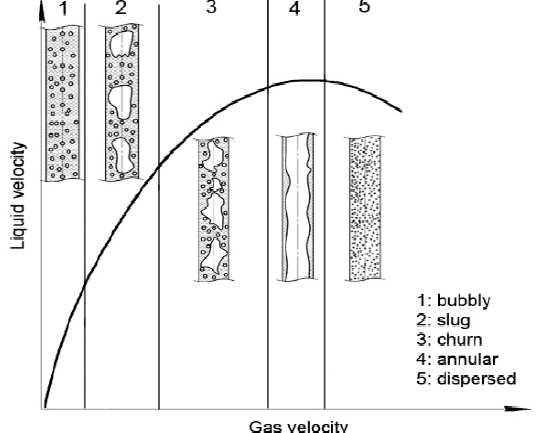
Figure 3. Flow pattern transitions in vertical upward two-phase flow.